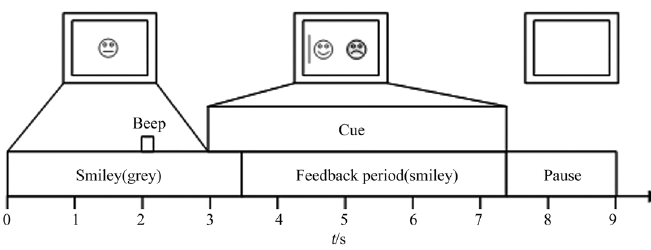
Figure 5. MI with recognition